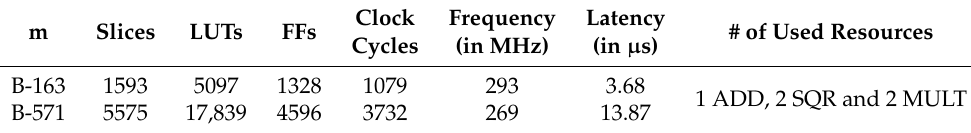
Table 1. Implementation results of the proposed high-speed elliptic-curve PM architecture after post-place-and-route over GF ( 2 m ) for m = 163 and 571 on a Xilinx XC7VX690T device. m